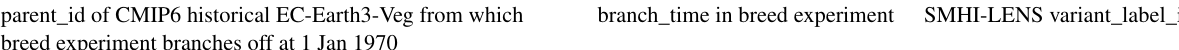
Table 1. Relationship between the members of the CMIP6 historical experiment done with EC-Earth3-Veg and the members of the SMHI- LENS. <n> is the realization_id (member) of the CMIP6 historical experiment (1–6). The branch_time 1974-1-1 is only used for r1 and r2 of the CMIP6 historical experiment, yielding members 149 and 150 of the large